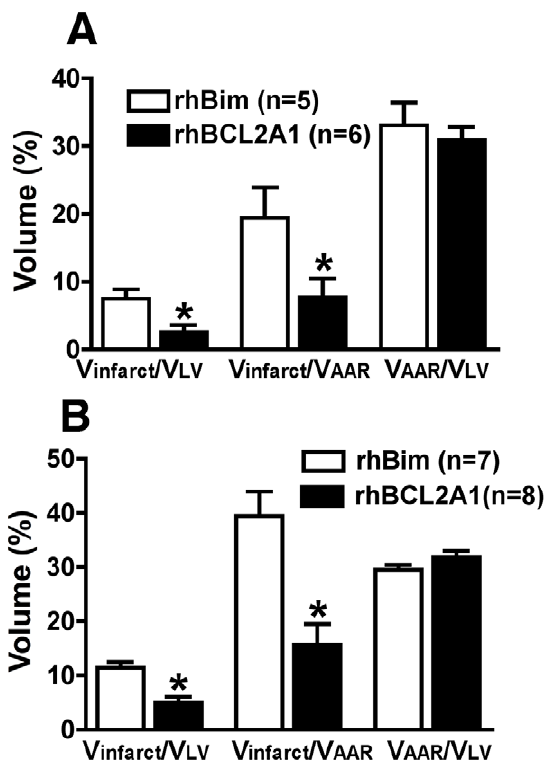
Figure 5. Treatment with rhBCL2A1 at the time of reperfusion reduces myocardial infarct size after I/R. Mice were subjected to LAD artery occlusion for 1 (A) or 2 (B) hours, and treated with subcutaneous rhBCL2A1 (1 m g/mouse) or rhBim (1 m g/mouse) at the time of reperfusion. Infarct size was determined after 24 hours of reperfusion (see Methods). Treatment with rhBCL2A1 at the time of reperfusion reduced infarct size at 24 hours of reperfusion (* p , 0.05).